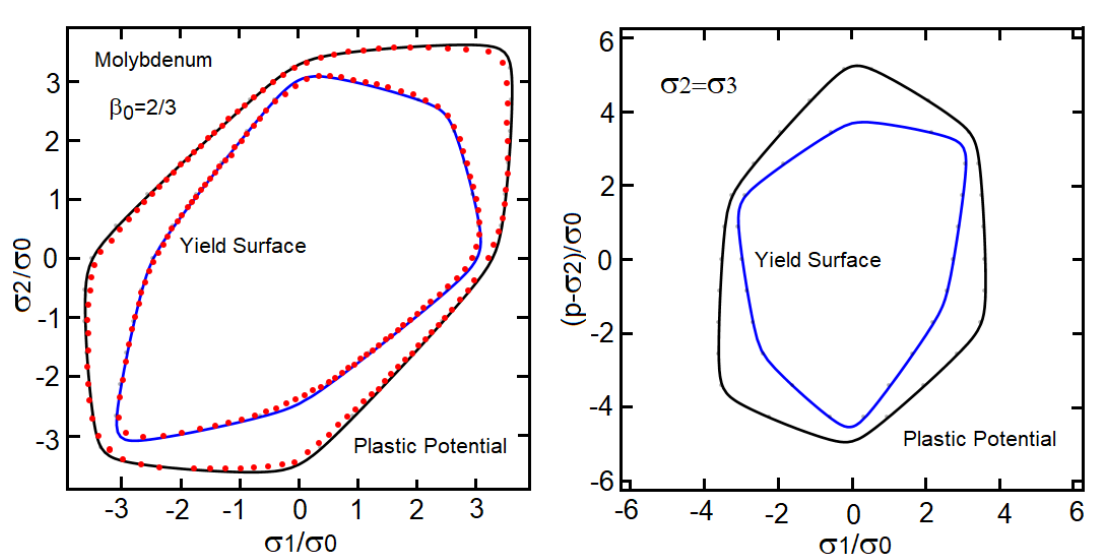
Figure 2. Yield surface (black line) and plastic potential (blue line) plotted on the plane of principal stresses 𝜎 1 and 𝜎 2 . Red data points are based on polycrystal model predictions with slip strengths informed by MD studies of glide of screw dislocations in bcc Mo, simulated by Gröger et al. [26,27]. The original source of the red data points is ref. [27]; the blue and black lines are the new output of the model set forth in Section 3 of the current work. The right-hand-side plot depicts the surface’s asymmetry on the plane of 𝜎 1 and (𝑝 − 𝜎 2 ) , where 𝑝 is hydrostatic pressure.